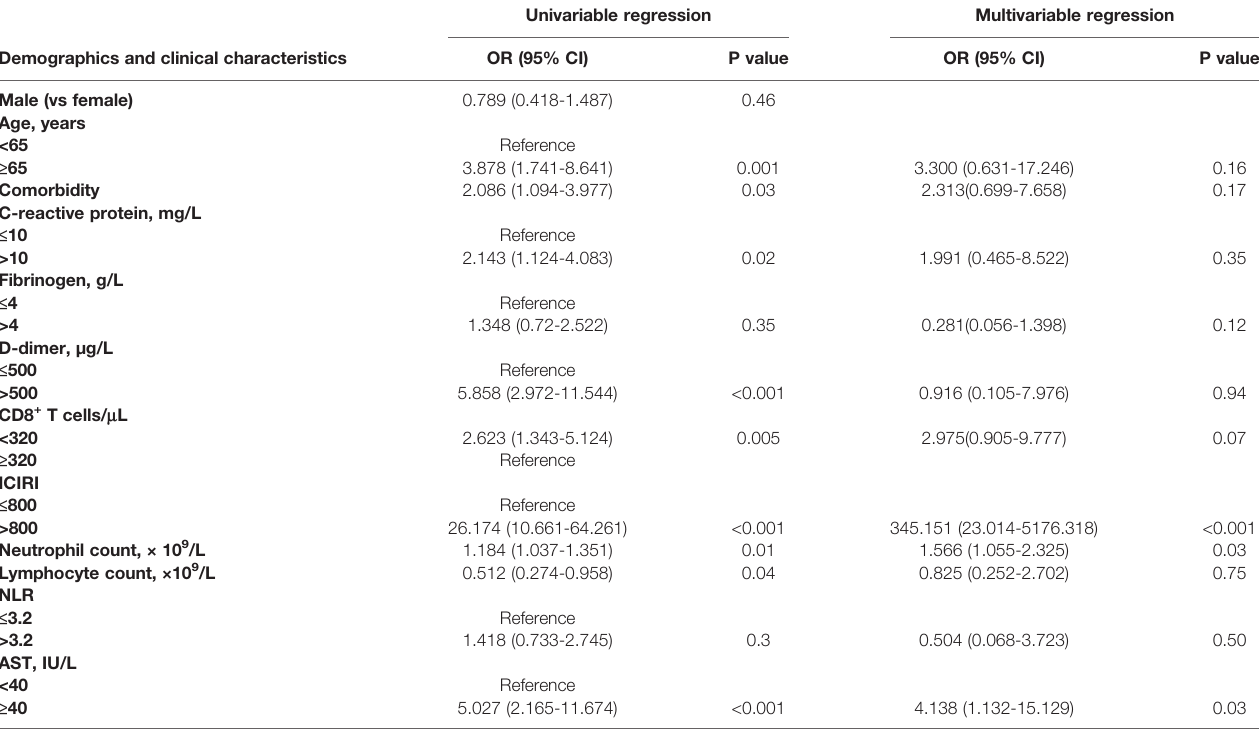
TABLE 2 | Risk factors associated with progression from mild or moderate to severe case.